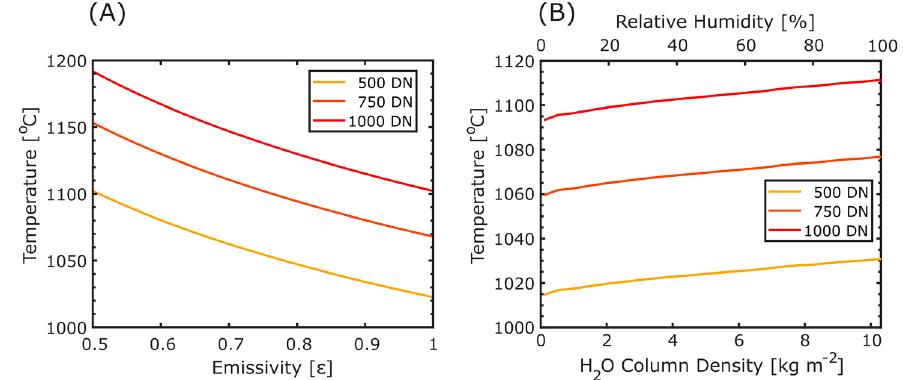
Figure 3. ( A ) A plot showing how retrieved temperature varies with emissivity of the object. Displayed at 3 different Digital Numbers (DNs), for a shutter speed of 1 ms and with a path transmission coefficient of 0.8789. ( B ) As ( A ) but displaying the effect of a water vapour correction on the retrieved temperature, i.e., larger estimated water vapour loadings in the path cause higher temperatures to be retrieved since there is more absorption of radiation across the path. For each data point the transmission coefficient was calculated as the mean between 800–1200 °C (see Section 2.3 for further explanation). Data is plotted for an emissivity of 0.95, with atmospheric temperature and pressure of 26.5 °C and 94,300 Pa, respectively; relative humidity is quoted using a path length of 412 m, used in the field tests on Masaya volcano (see Section 2.5).